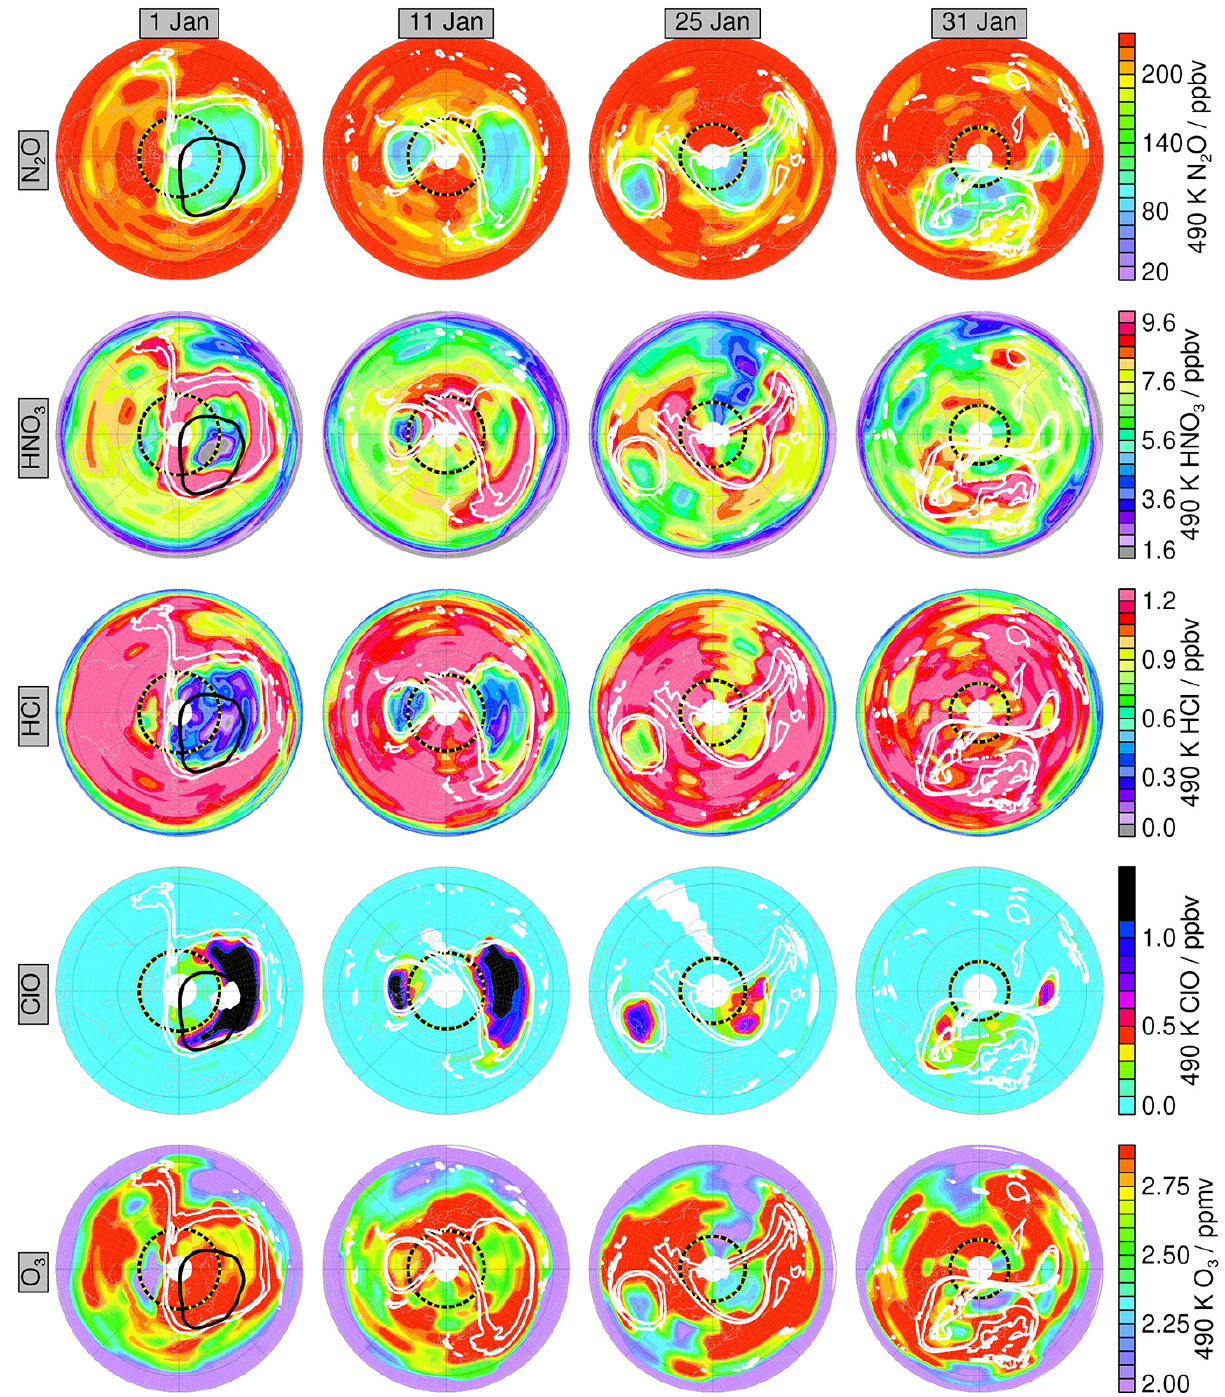
Figure 7. Maps of MLS trace gases on the 490K isentropic surface for selected days in January 2013, top to bottom: N 2 O (color bar range 20 to 236ppbv), HNO 3 (color bar range 1.6 to 10ppbv), HCl (color bar range 0 to 1.26ppbv), ClO (color bar range 0 to 1.4ppbv), and O 3 (color bar range 2.0 to 2.9ppmv). Yellow/black dashed line shows the latitude of polar night. White overlays are sPV contours of 1.2 and 1 . 6 × 10 − 4 s − 1 , representative of the vortex edge. The thick black contour (visible only on 1 January) outlines the region with temperatures less than 196K, the approximate chlorine activation threshold. Projection is orthographic, with 0 ◦ longitude at the bottom and 90 ◦ E to the right. Thin black circles show 30 and 60 ◦ N